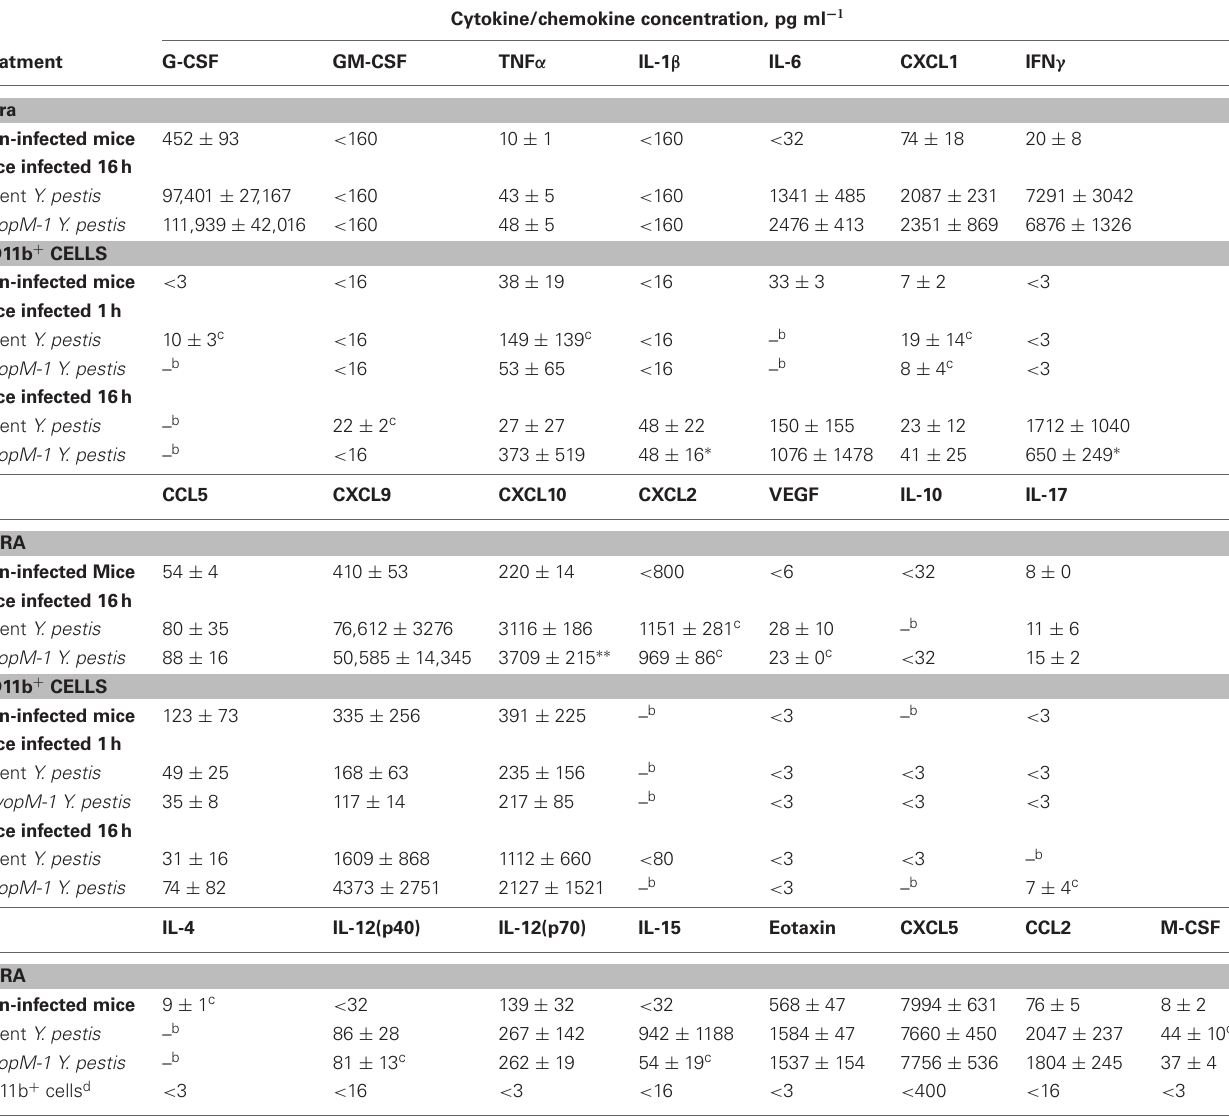
a < signifies that data from all three experimentswere below the detection limit. Other values without a superscript are average ± SD based on data that were above the detection limit in all three experiments. b –denotes that there was only one response above the detection limit; the other two experiments returned data that were below the detection limit. c Average ± the range from two experiments; the third experiment returned data that were below the detection limit. d CD11b + cells from all treatment groupsreturned responses below the detection limit for this set of genes, with the exception of mice infected for 16h with